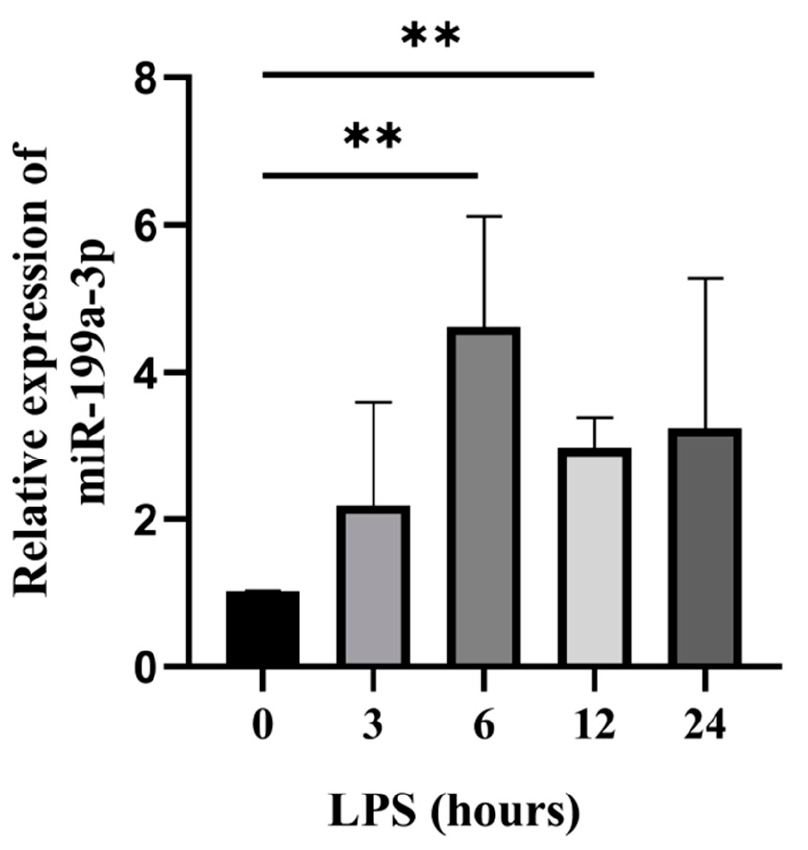
Figure 1. The expression of bta-miR-199a-3p was up-regulated in the LPS-induced MAC-T cells. The qRT-PCR analysis of bta-miR-199a-3p expression in the LPS-induced MAC-T cells at different times. The GAPDH and RPS18 genes were used as the internal controls. ** refers to p <